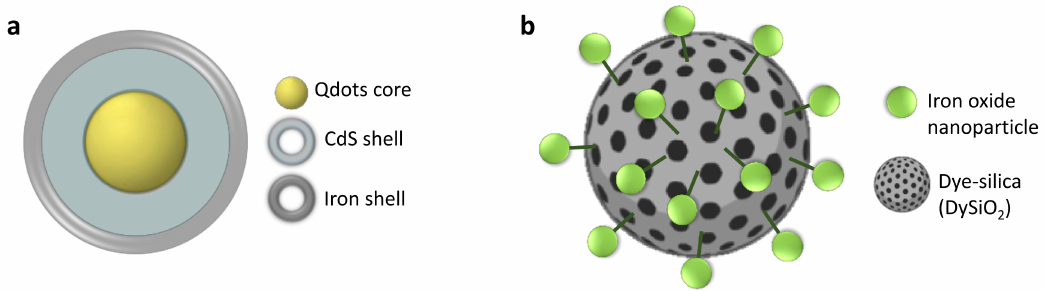
Figure 7. General strategies for MRI–OI dual agent synthesis based on the association approach. ( a ) Core–shell nanoparticles; ( b ) core–satellite. Adapted with permission from [15], Copyright 2021 Elsevier